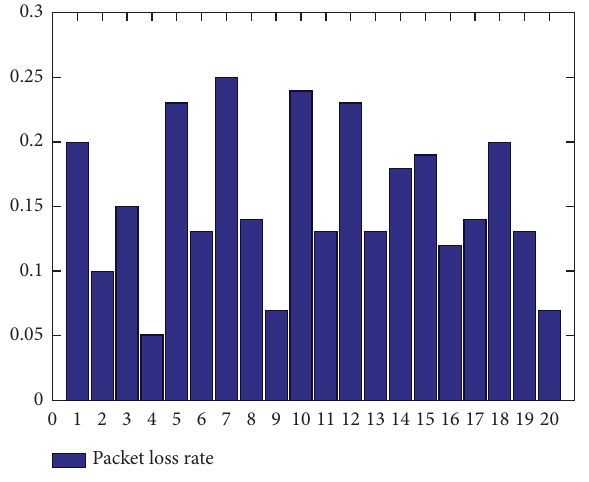
Figure 11: Average delay of nodes.